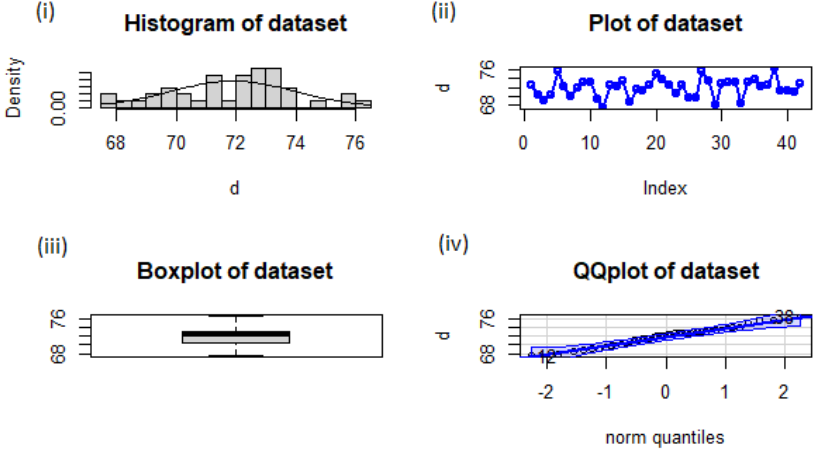
Figure 3. IoTDixon complete dataset normal distribution evaluation ( i ) histogram with density curve (top-left), ( ii ) plot of data points, ( iii ) box plot, and ( iv ) QQ